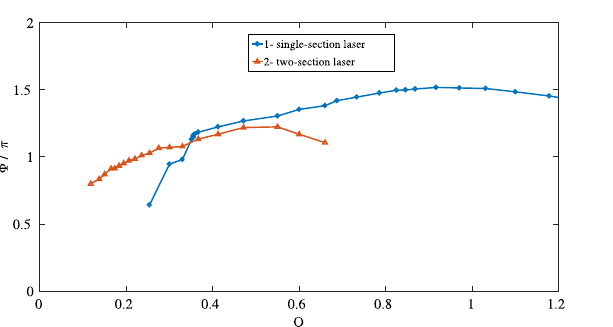
Figure 9. Dependencies of the pulse area at the output of the amplifying medium on Q for a single- (curve 1) and for a two-section laser (curve 2). The area was calculated numerically as the integral of the envelope over the complete roundtrip. This figure was created with Matlab R2016b (http://www.mathw